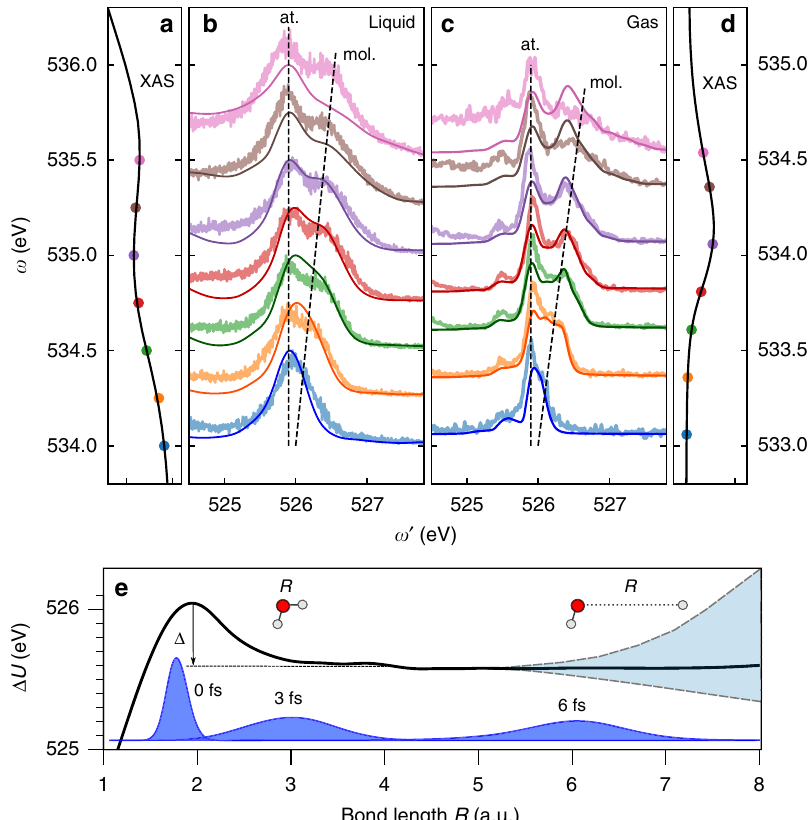
Fig. 5 Dynamical origin of the splitting of the 1 b 1 peak. Comparison of the dispersion of the split components in experimental RIXS spectra of liquid ( b ) and gas-phase water ( c ) at the pre-edge region. The panels a , d indicate the corresponding excitation energies in the XAS pre-edge region for liquid and gas- phase water. c includes theoretical gas-phase RIXS spectra (solid lines). Solid lines in the b show liquid spectra σ liquid ( ω ′ , ω ) calculated by convolution of the experimental gas-phase spectra σ gas ( ω ′ , ω ) with the structure function ρ ð ω 1 ′ (cid:1) ω ′ Þ (see Eq. (8)) with γ (FWHM) = 0.35 eV. Both liquid ( b ) and gas- phase ( c ) spectra display a nondispersive component (pseudo-atomic peak) and a molecular band following the Raman dispersion law. e illustrates schematically how the pseudo-atomic peak is formed near equilibrium ( R = 3 a.u.) as the PECs of the core-excited U c ( R ) and fi nal U f ( R ) states become almost parallel: Δ U = U c ( R ) − U f ( R ) ≈ const. The parameter Δ ≈ 0.45 eV is the splitting between molecular and pseudo-atomic peaks on top of the XAS